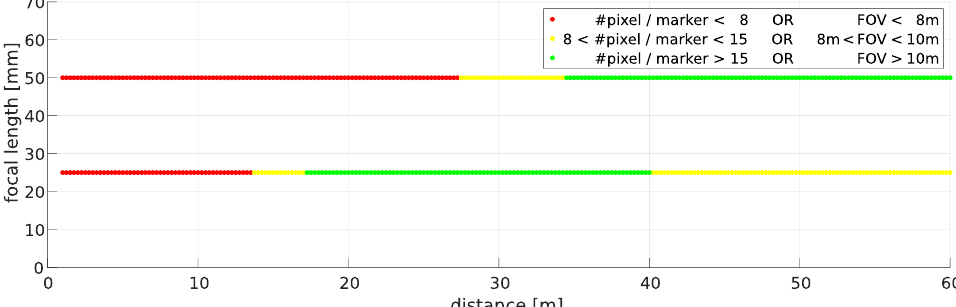
Figure 9. Operating range of different focal lengths with the Sony IMX540 as a function of the field of view and the number of imaged pixels in the image for a 66mm sized marker.